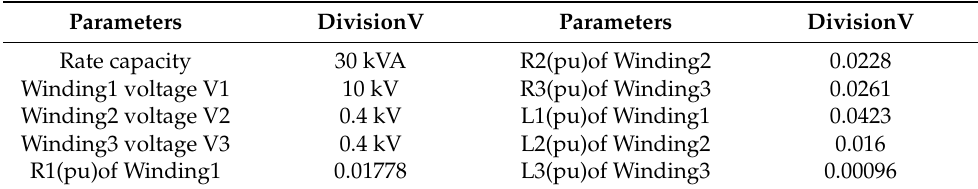
Figure 8. Block diagram of HIAF system in MATLAB. Table 1. Inductive filtering transformer